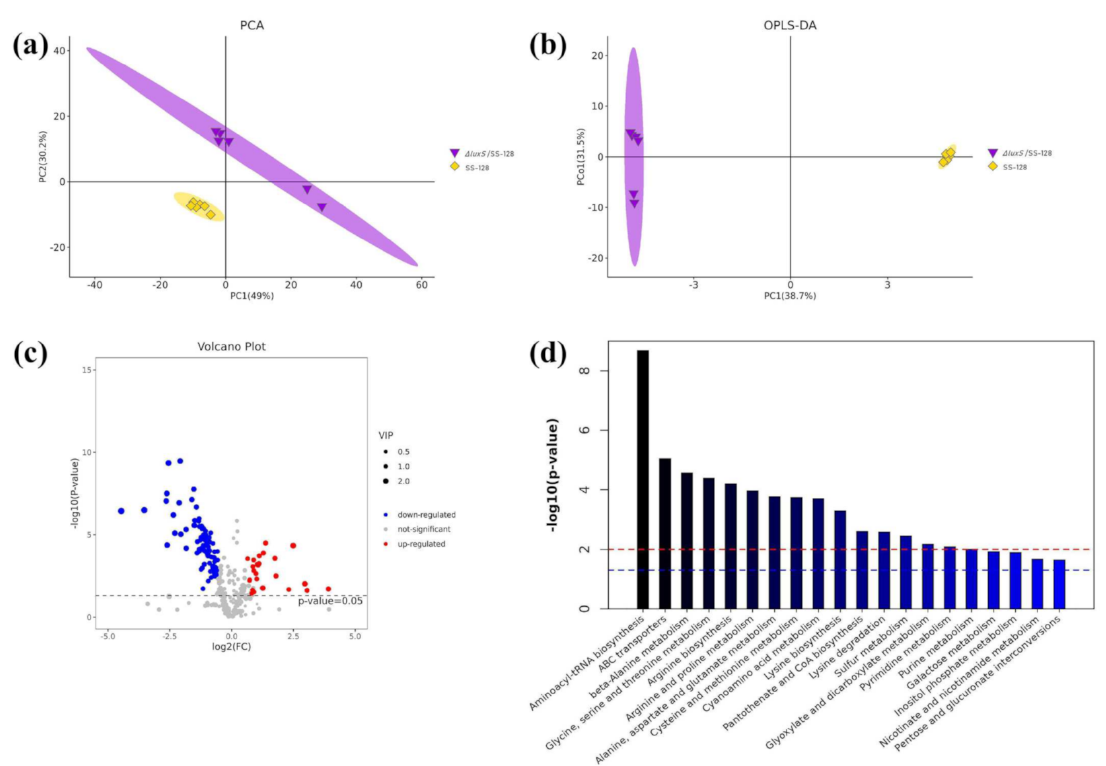
Figure 5. Changes in the metabolite contents compared the luxS mutant group with the control by GC–MS. The PCA ( a ), OPLS-DA ( b ), volcano plot ( c ), and metabolic pathway enrichment map-Top 20 ( d ) between ∆ luxS /SS-128 and SS-128 under the cut off of p < 0.05 ( ∆ luxS /SS-128 vs. SS-128). The red line and blue line in ( d ) indicate p = 0.01 and 0.05,